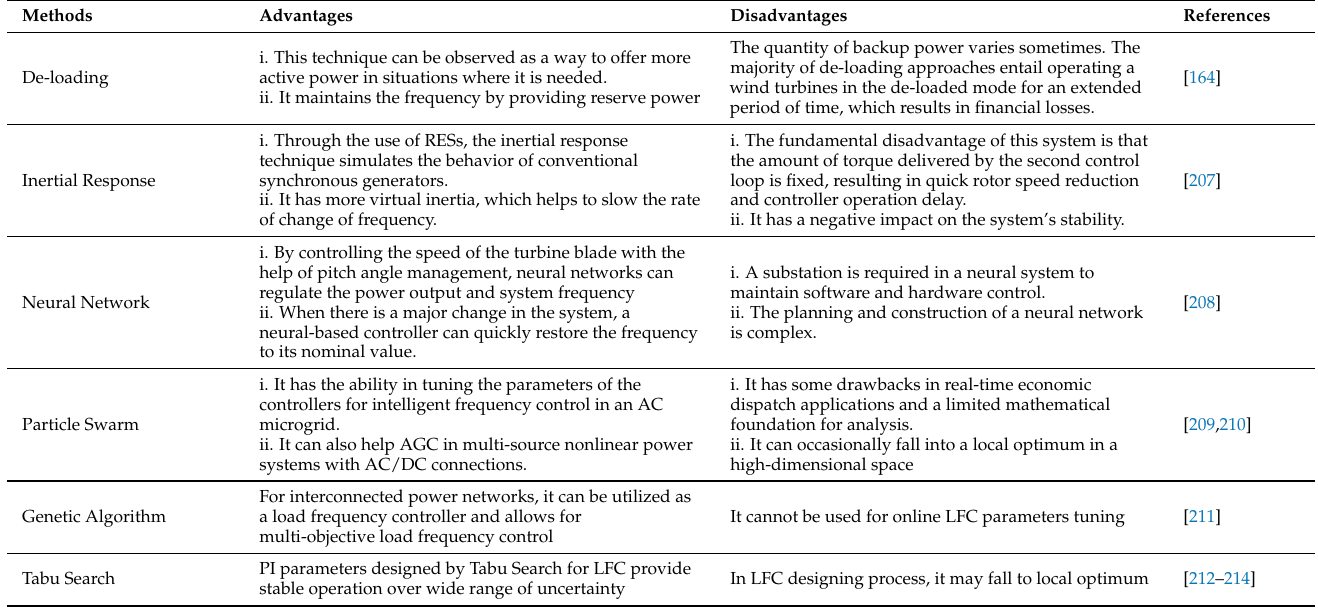
Table 3. Comparison of frequency control methods without auxiliary